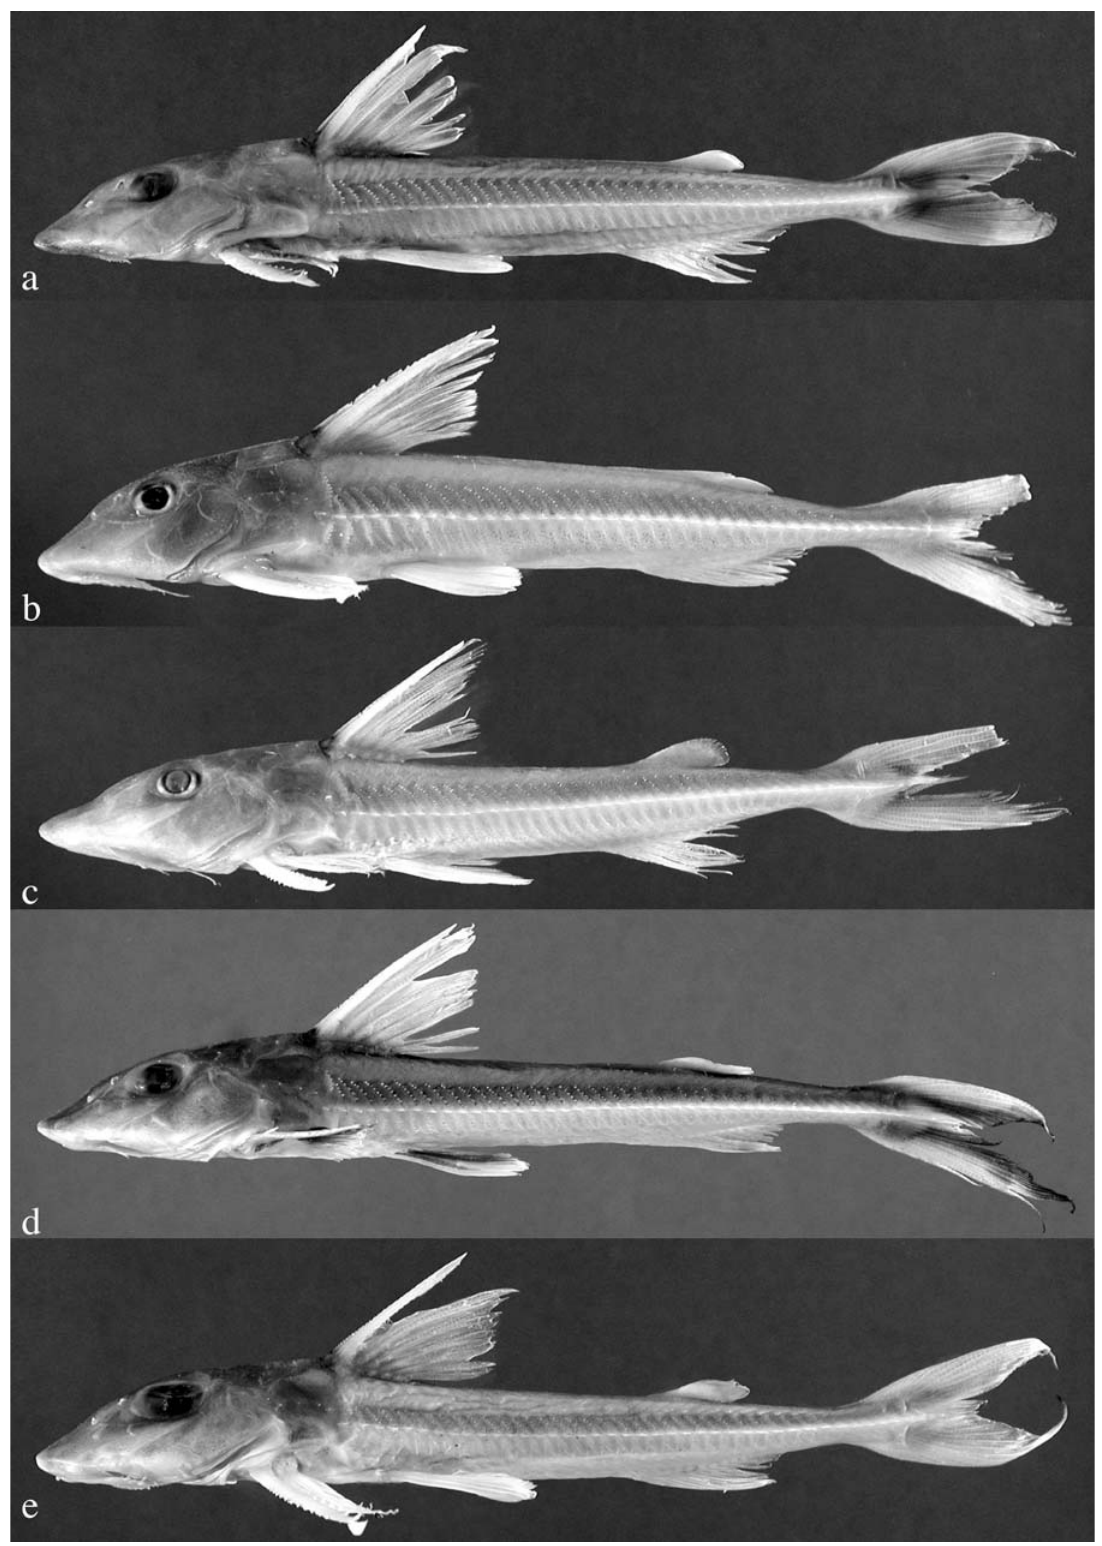
Fig. 18. Juvenile and subadult Leptodoras (Amazon basin). a. L. acipenserinus , FMNH 97140 (SL 113.3 mm), río Coca (Napo dr.), Napo, Ecuador. b. L. acipenserinus , ANSP 178467 (SL 107.9 mm), río Nanay, Loreto, Peru. c. L. cf. cataniai Nanay form, INHS 39814 (SL 109.2 mm), río Nanay, Loreto, Peru. d. L. cf. cataniai Amazon form, ANSP 180925 (SL 120.3 mm), rio Iça, Amazonas, Brazil. e. L. cataniai , ANSP 180912 (SL 104.6 mm), rio Negro, Amazonas,